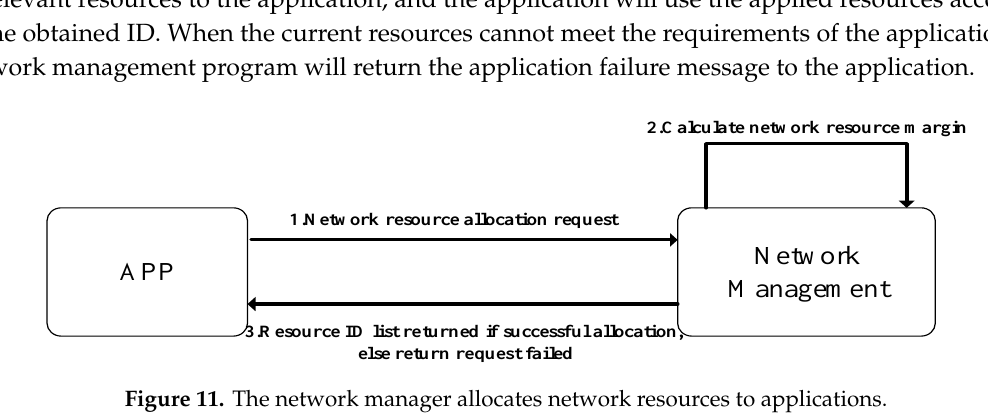
Figure 11. The network manager allocates network resources to applications.